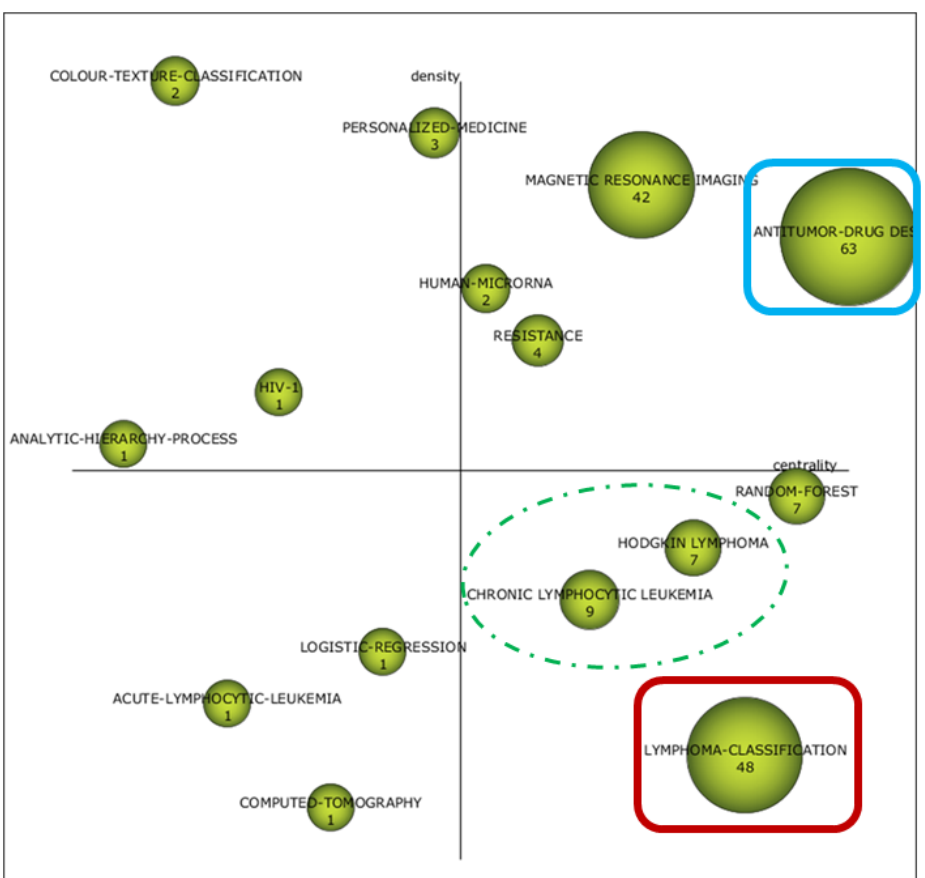
Figure 4. Two-dimensional space layout of research themes on AI and ML applications to diagnostic pathology in lymphoid neoplasms according to Callon ´ s density (vertical axis) and Callon ´ s centrality (horizontal axis) as shown by the package SciMAT. Strategic diagram of the cognitive framework for the period 2015–2020. Themes that recur over time have been marked in the same color (blue). The dashed marks in green show clinical entities that have appeared in the last period, compared to non-Hodgkin’s lymphomas in the previous diagrams, also shown in green with continuous lines. The second topic that agglutinates a higher number of documents in the period 2015–2020 (lymphoma classification) has been highlighted in